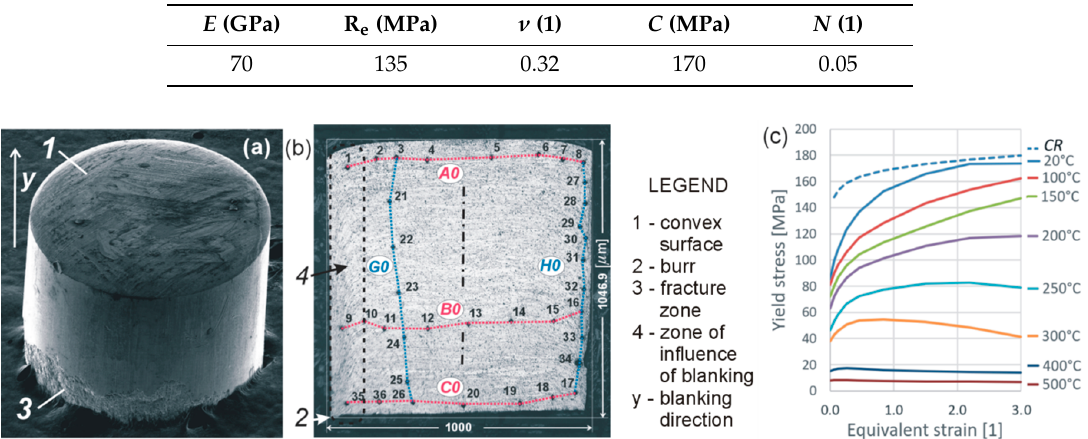
Table 2. Mechanical properties of specimen materials (cold rolled— CR ).